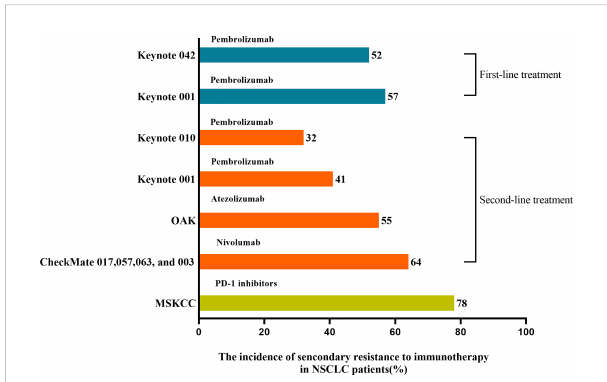
FIGURE 2 The incidence of secondary resistance to immunotherapy in NSCLC patients. ICIs applied as fi rst- and second-line treatment in treating NSCLC patients resulted in 52%-57% and 32%-64% rates of secondary resistance, respectively. MSKCC found that 78% of patients who acquired an initial response to PD-1 inhibitors further developed secondary